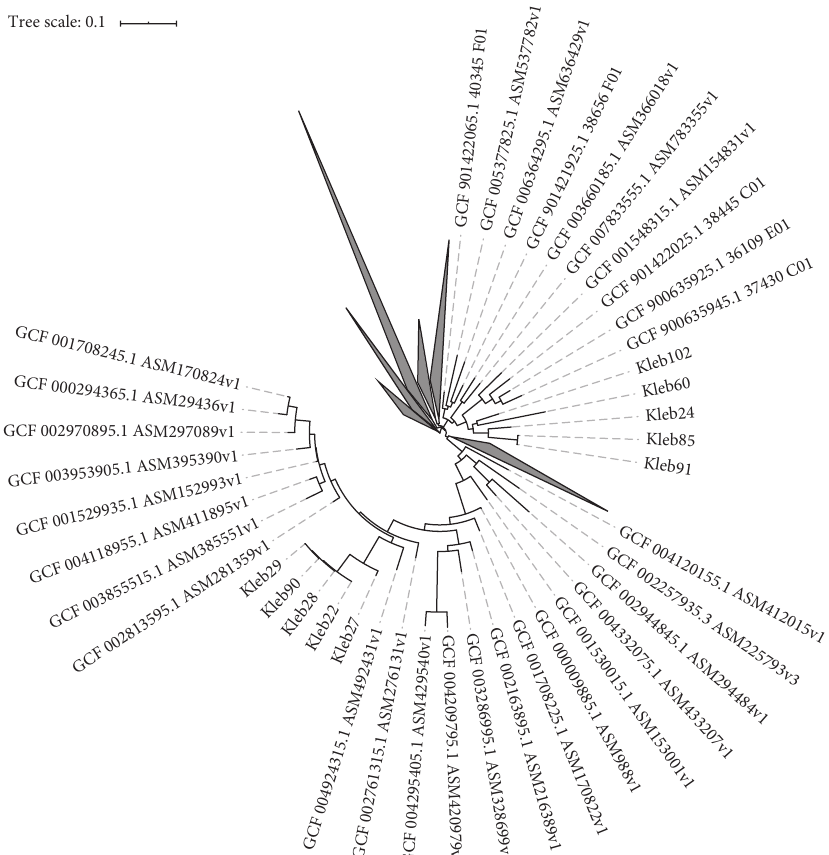
Figure 1: Phylogeny tree showing the relationship between 10 studying K. pneumoniae isolates and reference strains; built using Roary, the pangenome software; visualized using